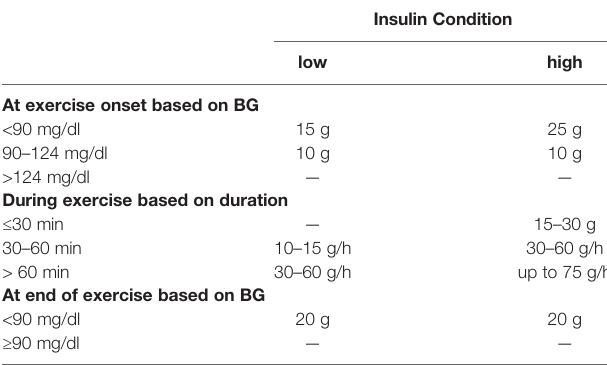
TABLE 3 | Consensus guidelines: CHO intake before, during and after